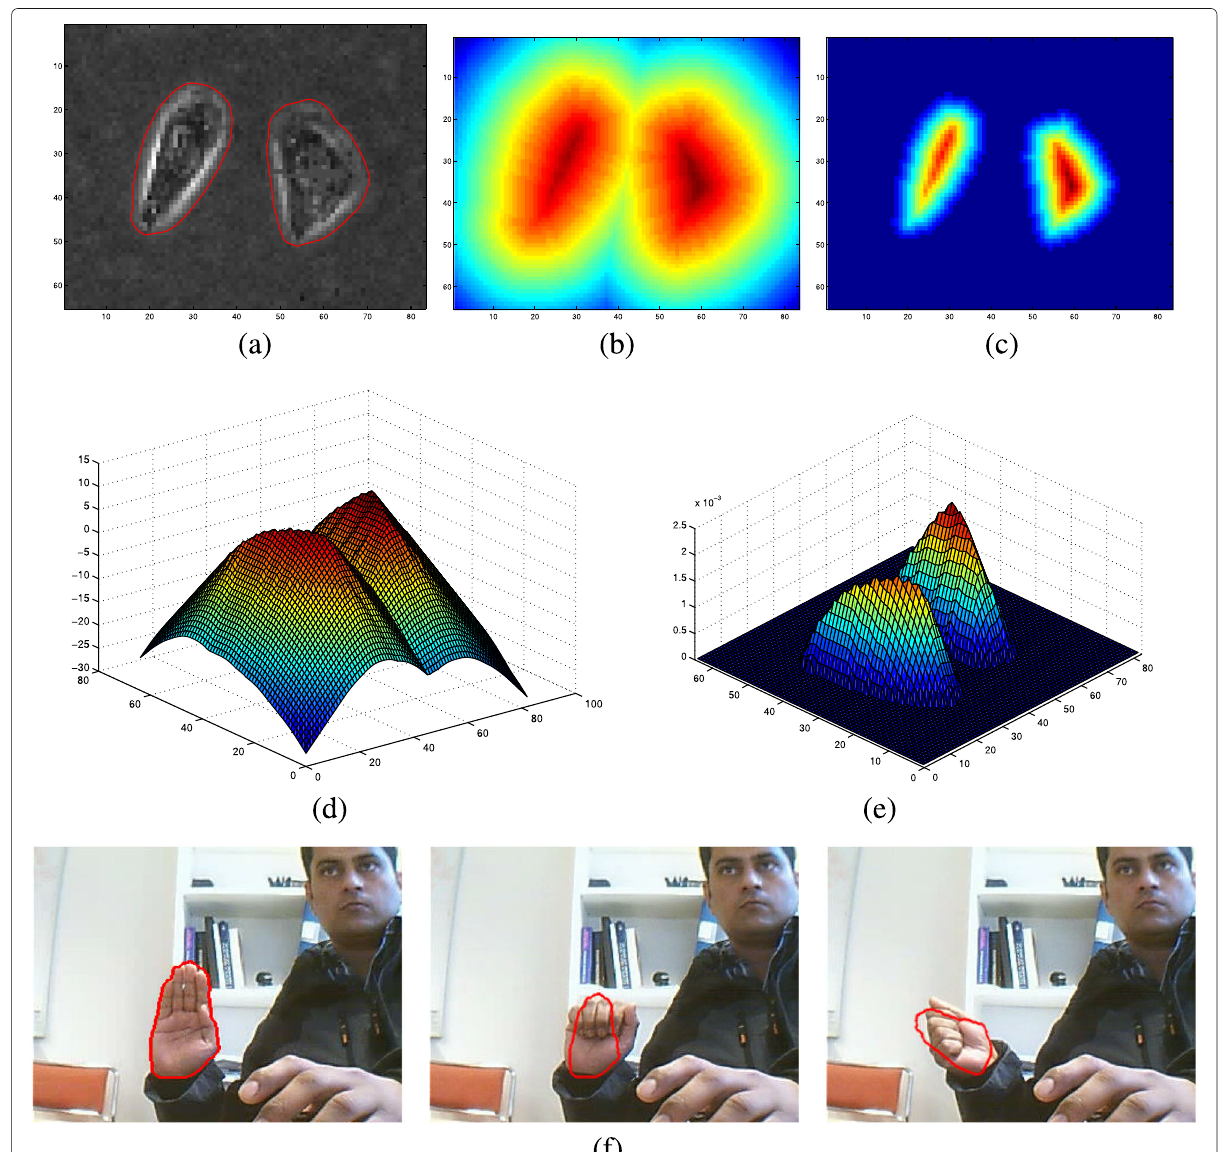
Fig. 2 Illustration of the level set kernel mechanism. d and e are the corresponding three-dimensional map of the level set function and kernel, the frame numbers of f are 0, 87, and 107, respectively, in hand sequence. a Target contour. b Level set function. c Level set kernel. f Tracking out-plane deforming target with constant kernel